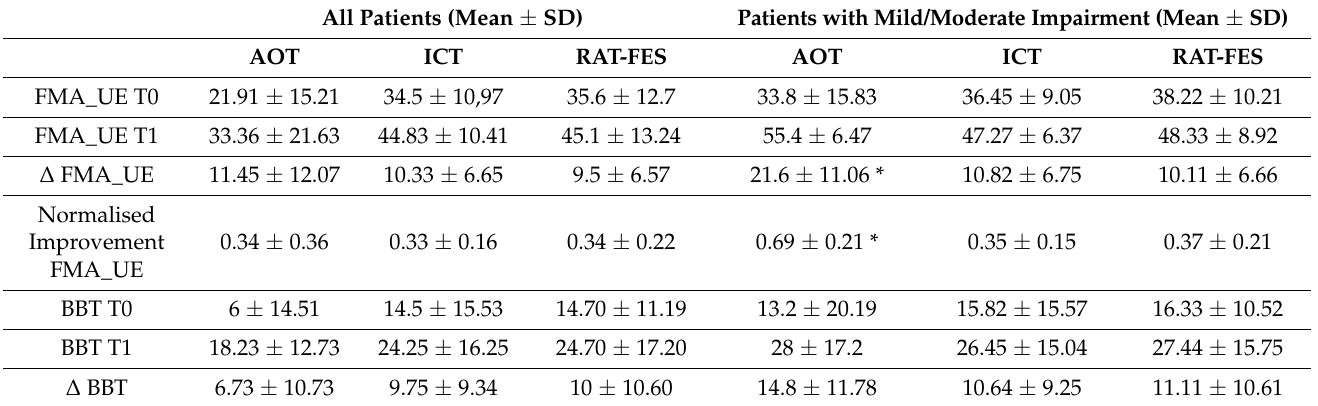
Table 3. Mean ± SD of clinical data in the three groups of treatments.